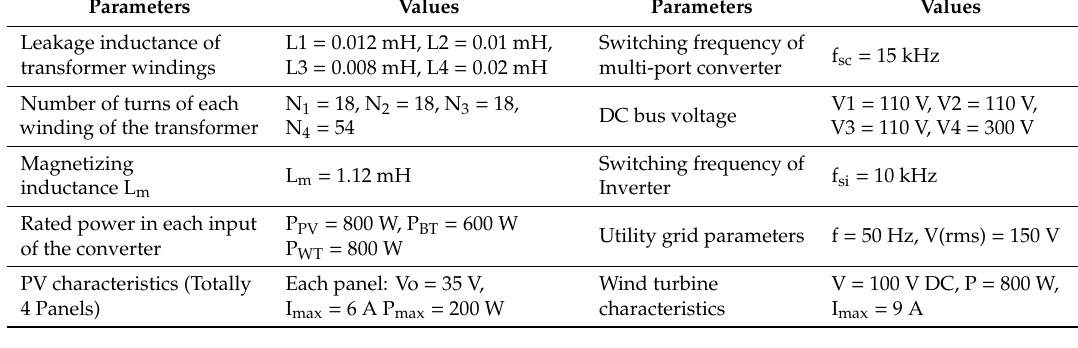
Table 1. System parameters for numerical simulations.